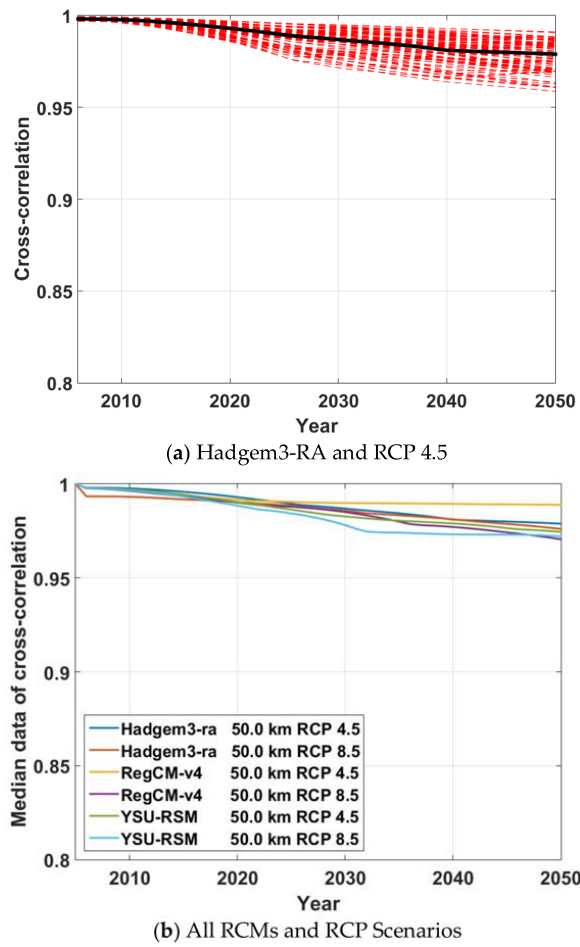
Figure 13. Cross-correlation between present and future